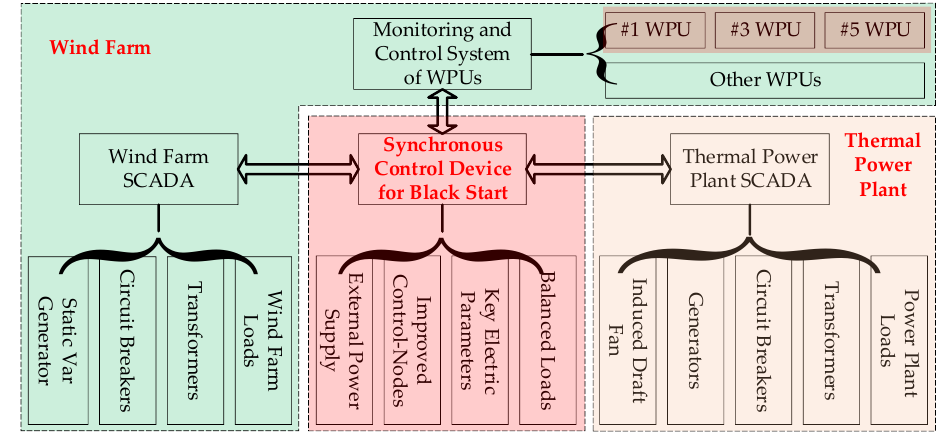
Figure 4. The logic relationship of SCDBS.